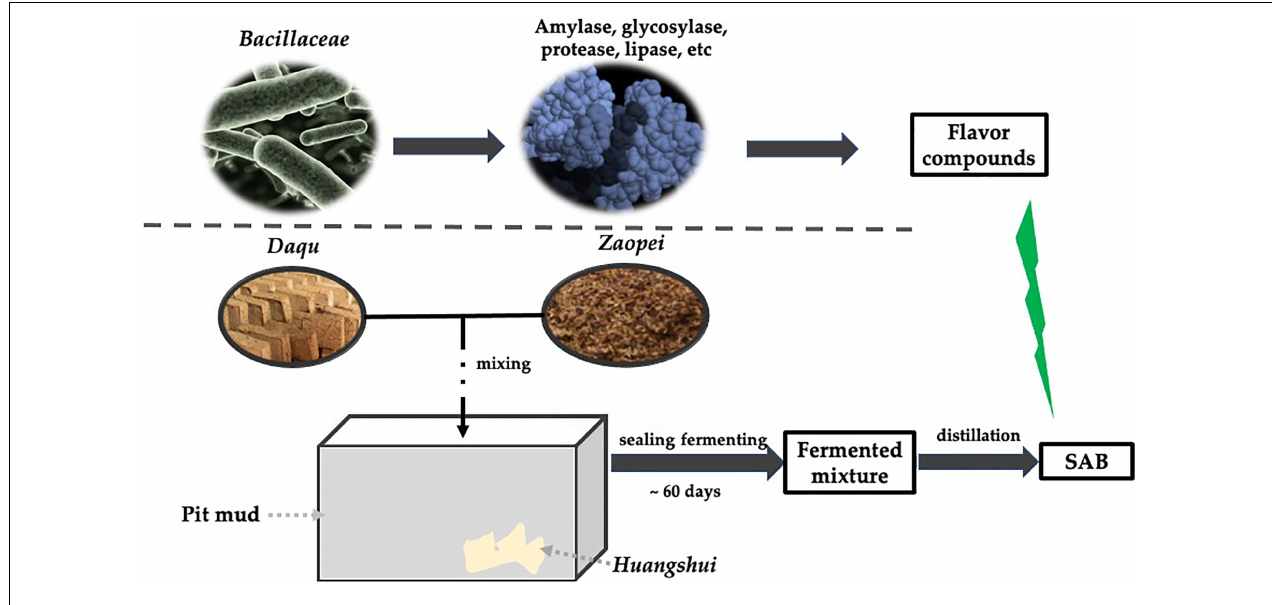
FIGURE 1 | Bacillaceae associated with the process of SAB brewing.